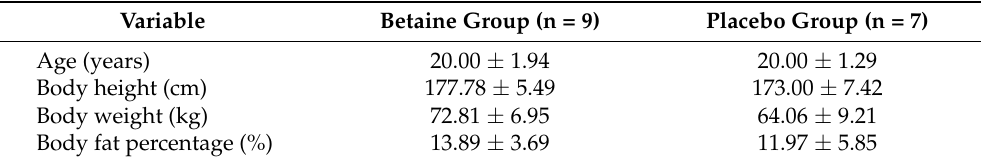
Table 1. Participant